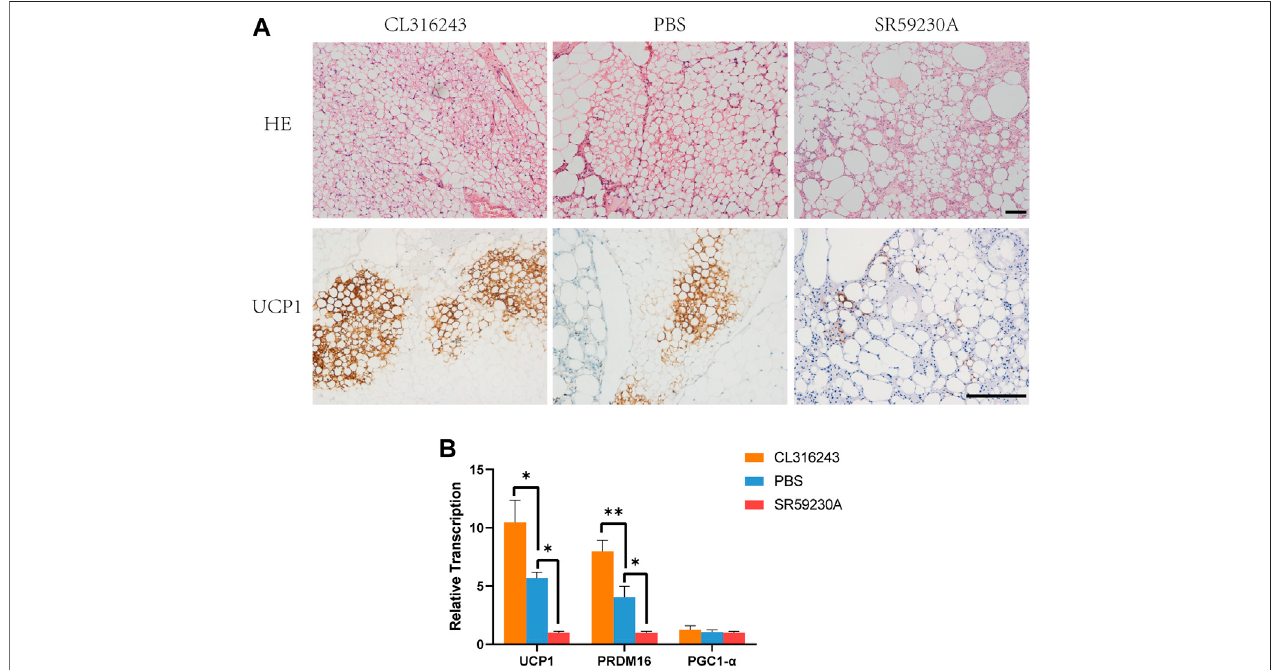
FIGURE 3 | Manipulation of the degree of browning of the grafts using CL316243 and SR59230A. (A) Histologic analysis showed that fat grafts from the upregulation group contained smaller and more multilocular adipocytes than the control group and downregulation group 2 weeks after transplantation. (above) Immunohistochemistryforthebeigeadipocytemarkeruncouplingprotein(UCP)-1showedalargernumberofUCP1-positivebeigeadipocytesintheupregulationgroup and a smaller number in the downregulation group, compared with the control group. (below) (B) There was a similar trend for the expression of browning-related genes (Ucp1 and Prdm16). There were no signi fi cant differences in the expression of Pgc1a among the groups. (* p < 0.05;** p < 0.01). Scale bar = 50 μ m.